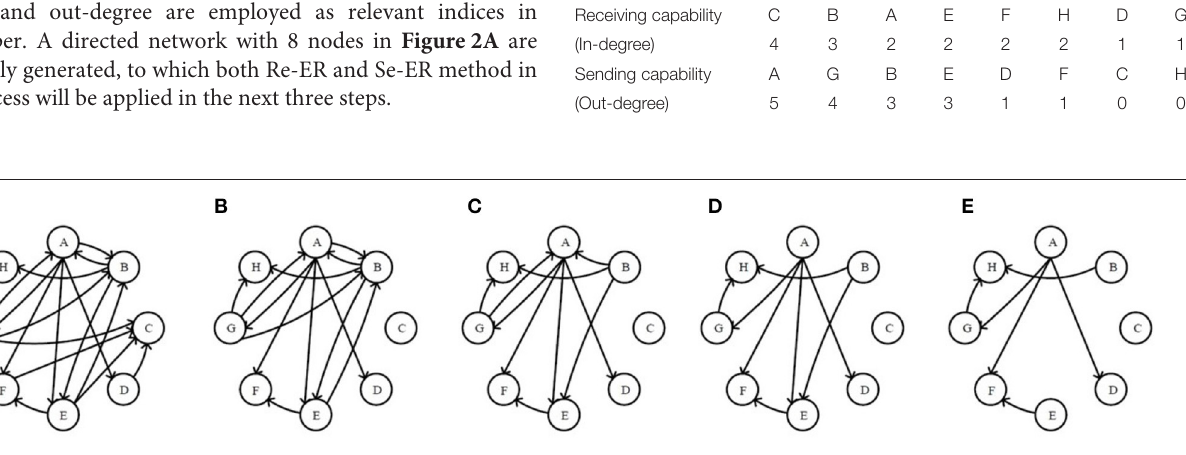
FIGURE 2 | The original network and the first four residual networks based on receiving-edge removal. (A) The original network. (B) The 1 stRN . (C) The 2 ndRN . (D) The 3 rdRN . (E) The 4 thRN .